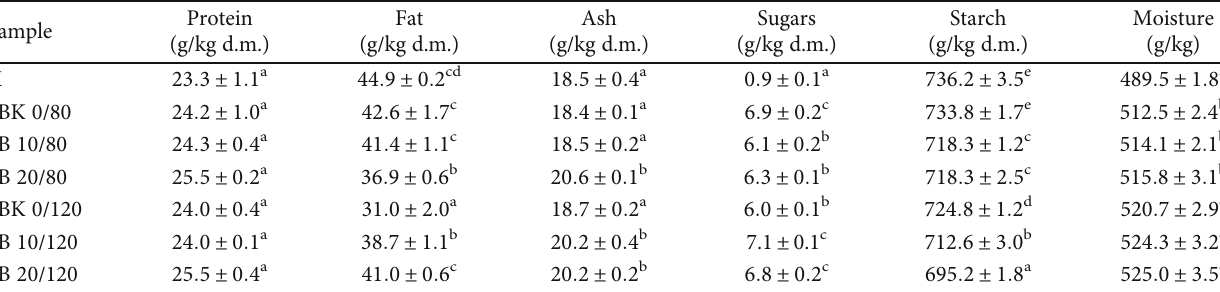
Table 1: Chemical composition of analyzed bread samples.